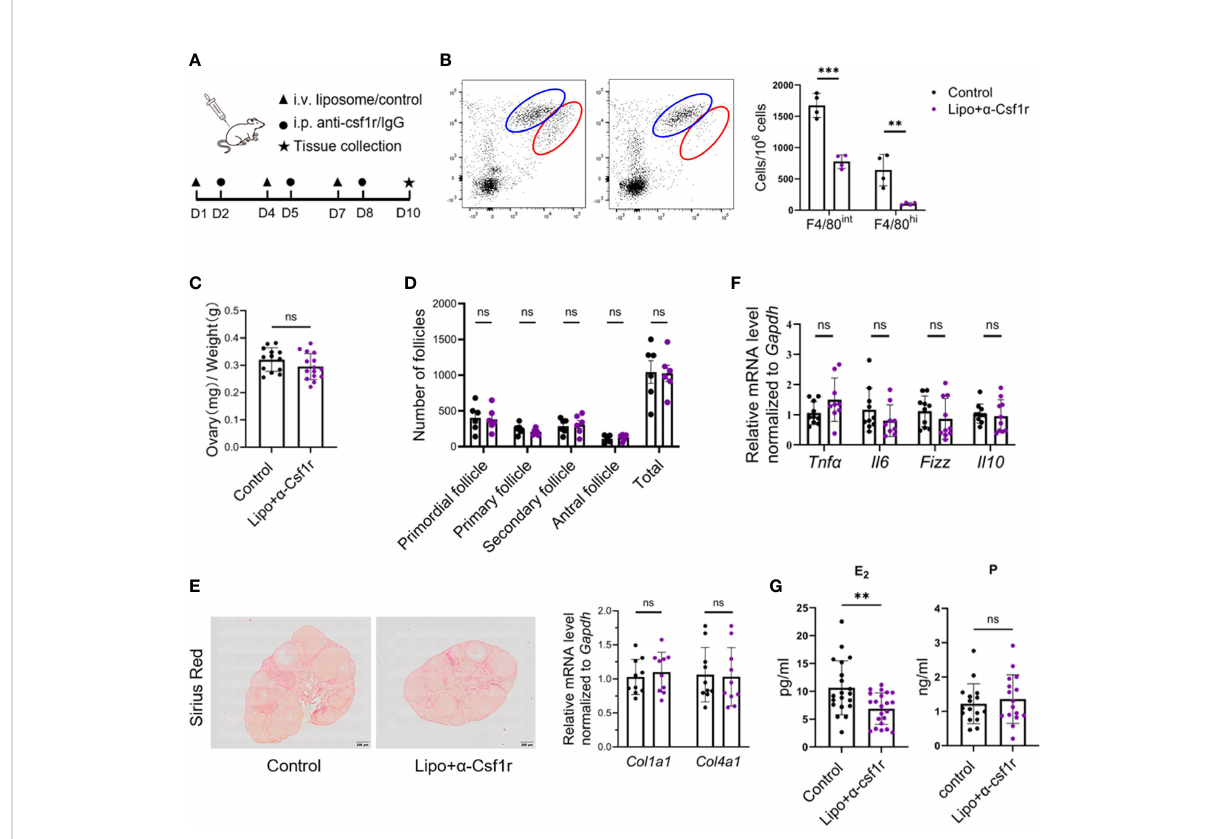
FIGURE 4 Disturbance of estradiol production by macrophage depletion. (A) Macrophage depletion experimental design. (B) Dot plots and histograms depict the two subsets of ovarian macrophages in clodronate+anti-CSF1r (lipo+ a CSF1r) treated and control antibody-treated (control) mice 48 h after the last treatment (n=4. Mean ± SEM). (C) Ovarian index of lipo+ a CSF1r treated mice and control mice (n=13~14. Mean ± SEM). (D) Follicle counts in lipo+ a CSF1r treated mice and control mice (n=6. Mean ± SEM). (E) Sirius red and quantitative RT-PCR analysis of Col1a1 and Col4a1 in the ovaries of lipo+ a CSF1r treated mice and control mice. Scale bar 200 m m. (F) Quantitative RT-PCR analysis of proin fl ammatory- and anti-in fl ammatory-related genes in the ovaries of two groups of mice (n=9. Mean ± SEM). (G) Estradiol (E 2 ) and progesterone (P) levels in lipo+ a CSF1r treated mice and control mice (n=20. Mean ± SEM). ns, no signi fi cance, **P < 0.01, ***P <